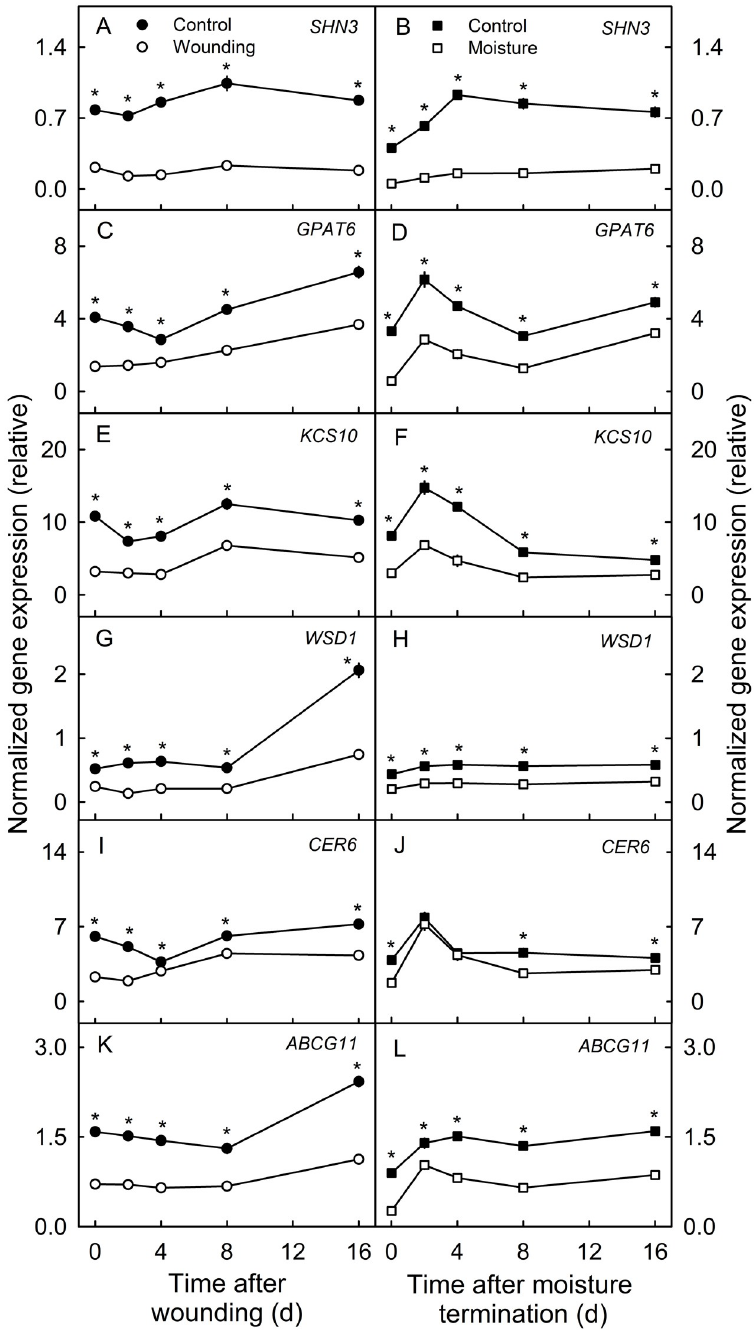
Fig 4. Time courses of change in the expression of genes involved in the synthesis of cutin monomers ( SHN3 , GPAT6 ) and wax constituents ( KCS10 , WSD1 , CER6 ) and their transport ( ABCG11 ) in the skin ‘Pinova’ apple fruit following wounding or following exposure of the fruit surface to moisture. Patches of fruit skin were wounded 40 days after full bloom (DAFB) by abrading the cuticle using fine sandpaper (‘Wounding’). For comparison, microcracks were induced by exposure of skin patches to surface moisture (‘Moisture’). Here, the fruit surface was exposed to surface moisture from 28 to 40 DAFB. Non-treated fruit served as control (‘Control’). Expression values are means ± SE of three biological replicates comprising six fruit each. The ‘ � ’ indicates significant differences between the wounded patch and its control or between the moisture exposed patch and its control, P � 0.05 (Student’s t-test).